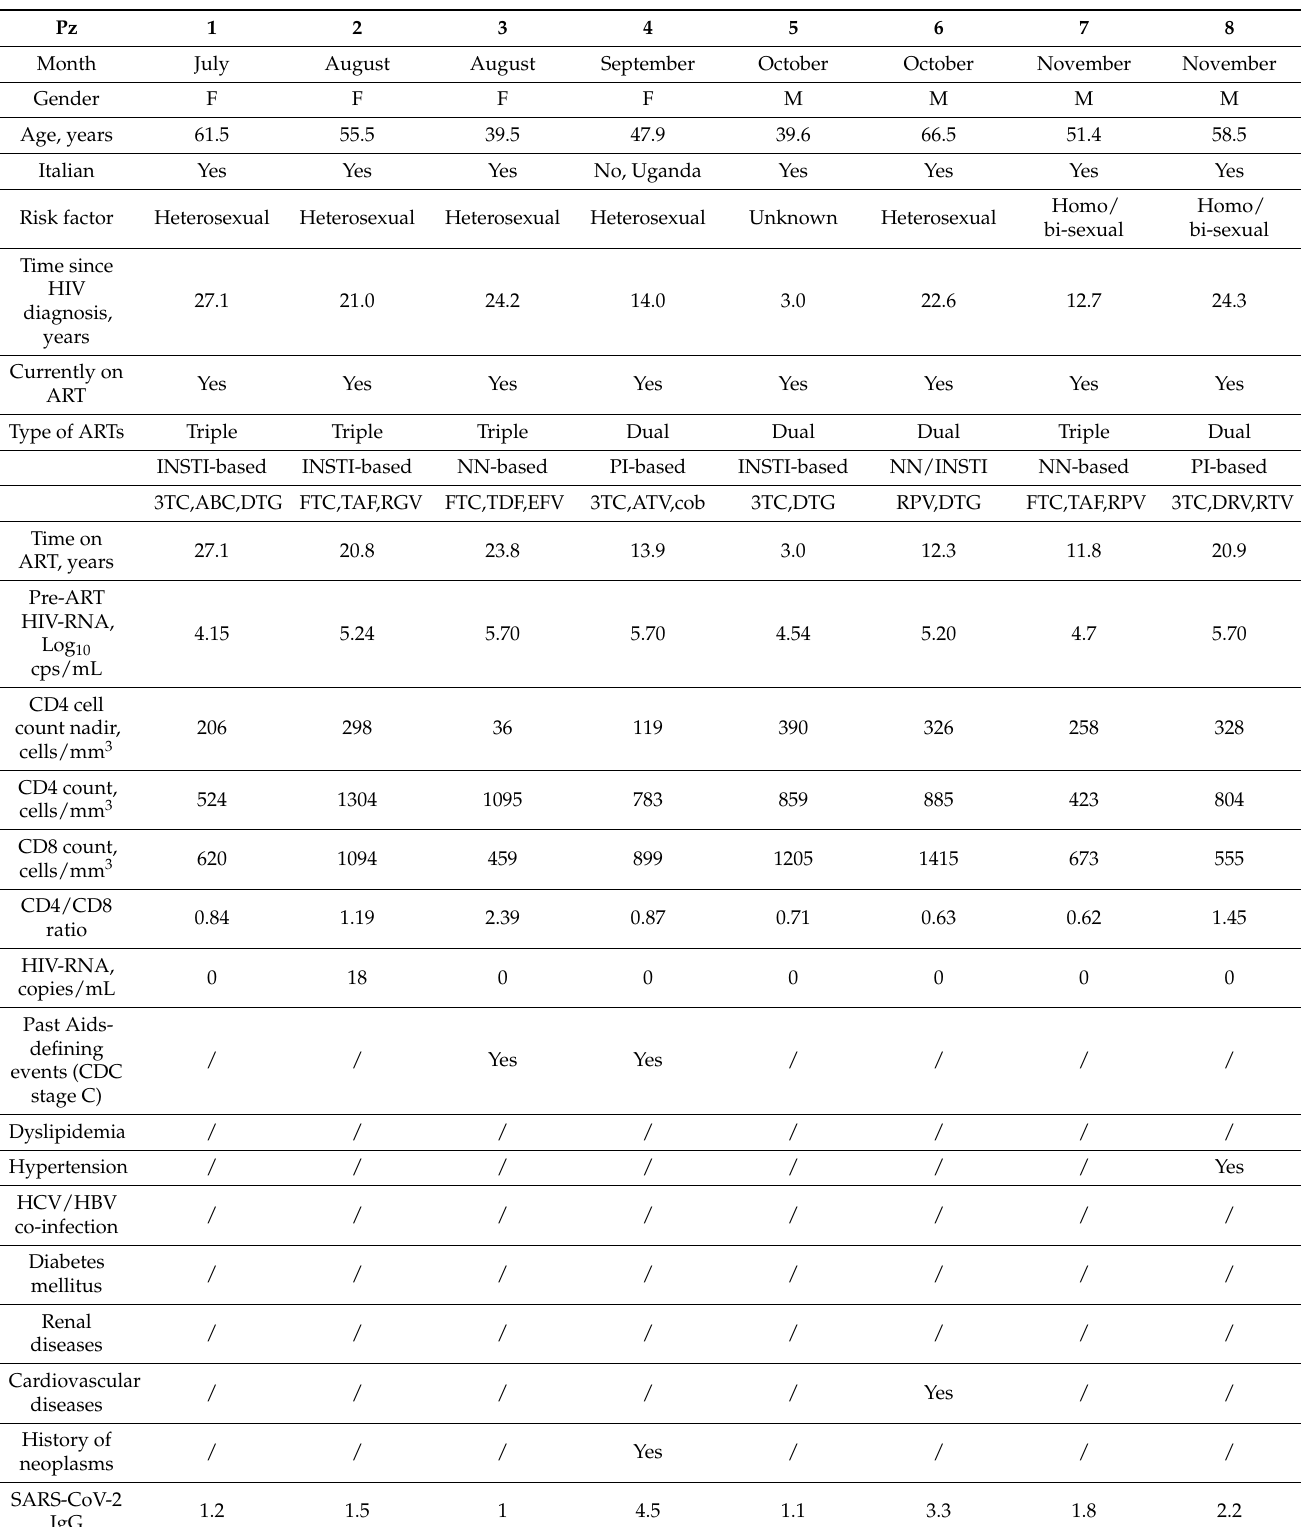
Table 2. Demographics, clinical and therapeutic characteristics of the eight SARS-Cov-2 IgG seropositive